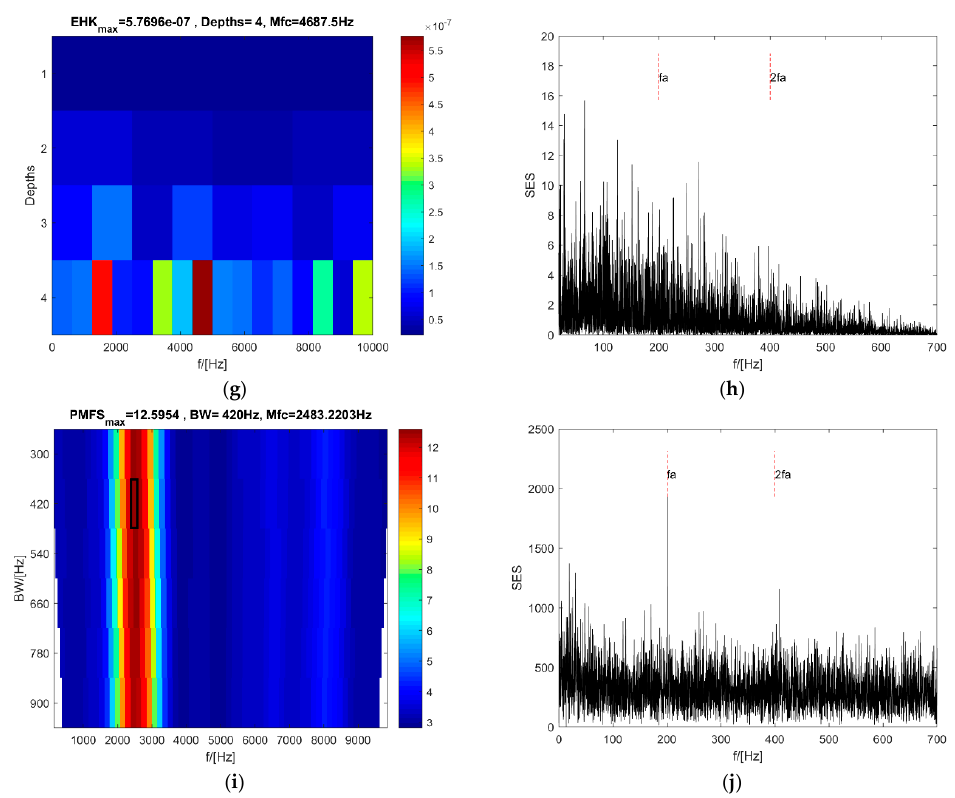
Figure 5. Analysis results of 4.2: ( a , b ) the synthesized signals before WGN noise is added and after WGN noise is added; ( c , d ) the protugram and the SES of its optimal frequency band; ( e , f ) the PMgram and the SES of its optimal frequency band; ( g , h ) the enhanced kurtogram and the power spectrum of its optimal frequency band; ( i , j ) the PMFSgram and the SES of its optimal frequency band.